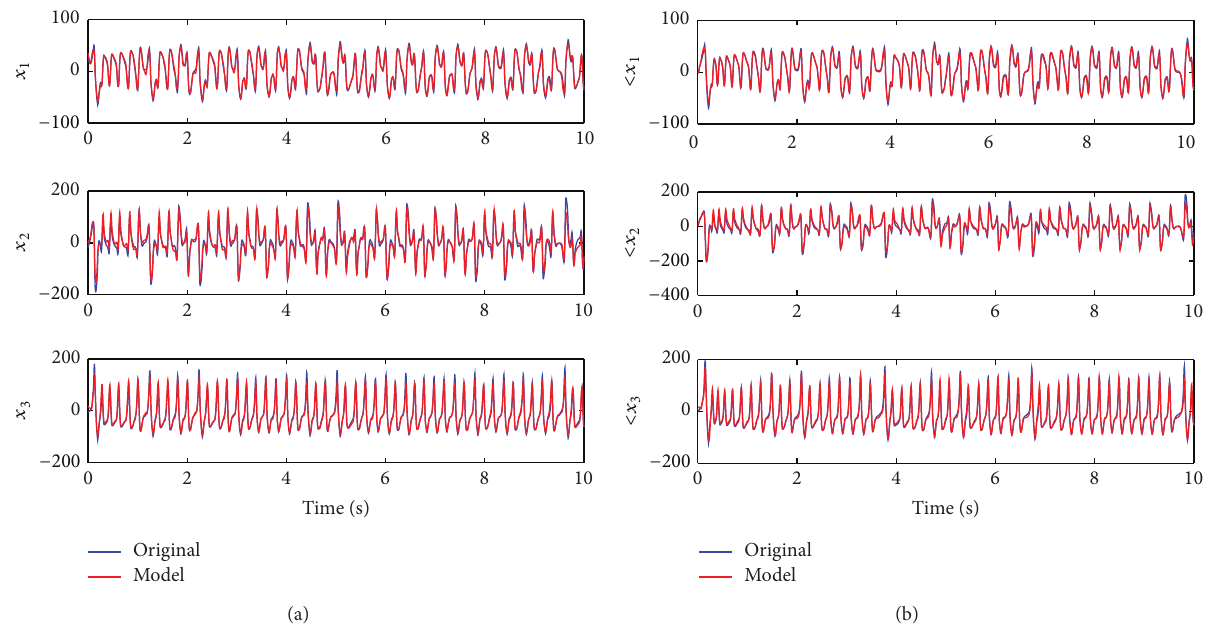
̇𝑋(𝑡) for original system and NN model. (b) The responses of